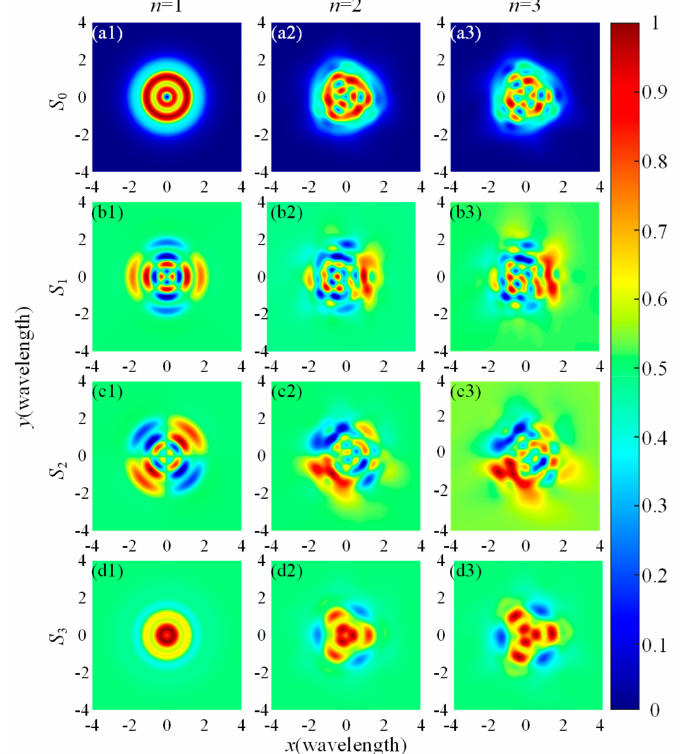
Figure 6. The Stokes parameters of different power exponents n in the transverse plane. ( l = 3, p ’ = 1, and δ = 0.005 m). The Stokes parameters of ( a1 – d1 ) the power exponents n = 1, ( a2 – d2 ) the power exponents n = 2, and ( a3 – d3 ) the power exponents n =